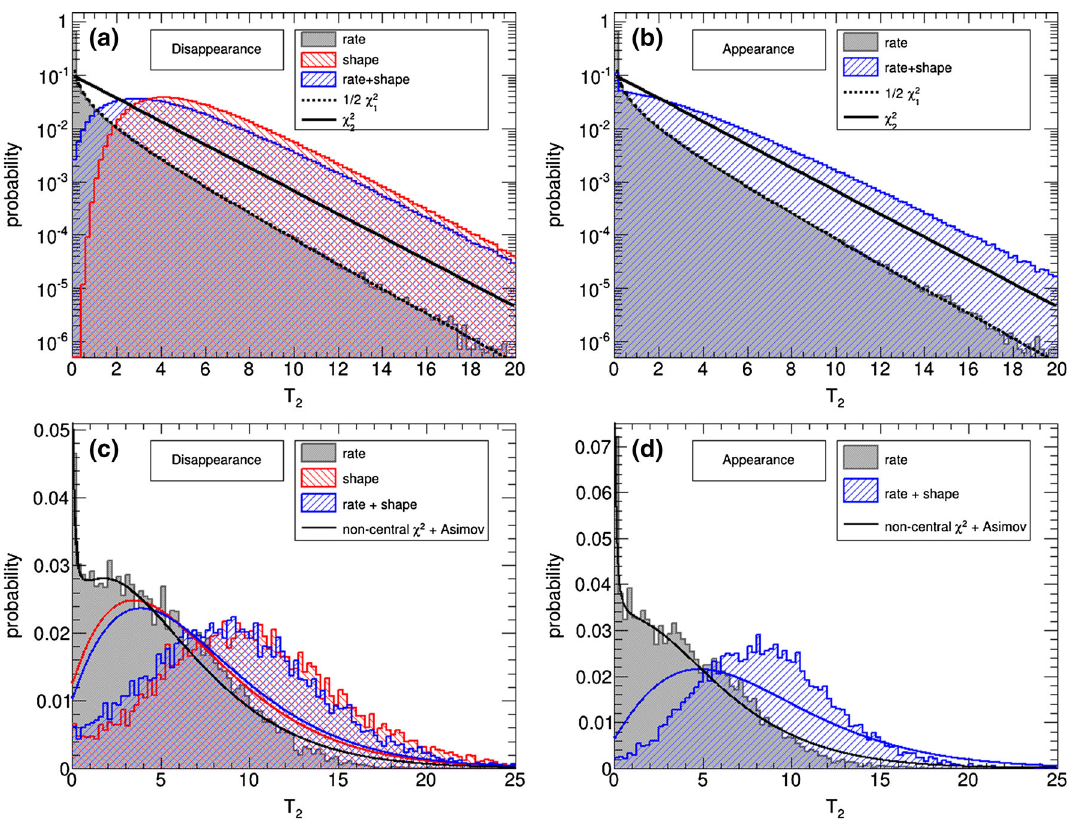
Fig. 8 Distributions of T 2 computed from an ensemble of pseudo- data generated assuming the no-signal hypothesis and their asymptotic formulas. The distributions are shown for a test of the no-signal hypothesis (panel a and b using 10 7 sets of pseudo-data) and of an oscillation hypothesis (panel c and d using 10 4 sets of pseudo-data). The oscillation hypothesis